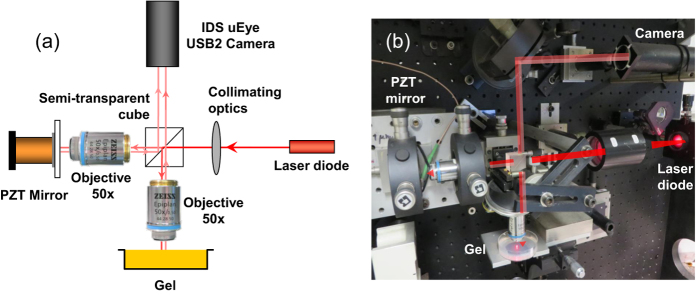
(a) Sketch of the experimental setup that consists in a Michelson Interferometer operated in reflection mode. (b) Photo of the real experimental setup. The scale is set by the diameter of the Petri dish of 50 mm. The experimental setup is placed in a box that can be closed with thick curtains to limit air convection that may otherwise artifically increase the gel thinning rate.